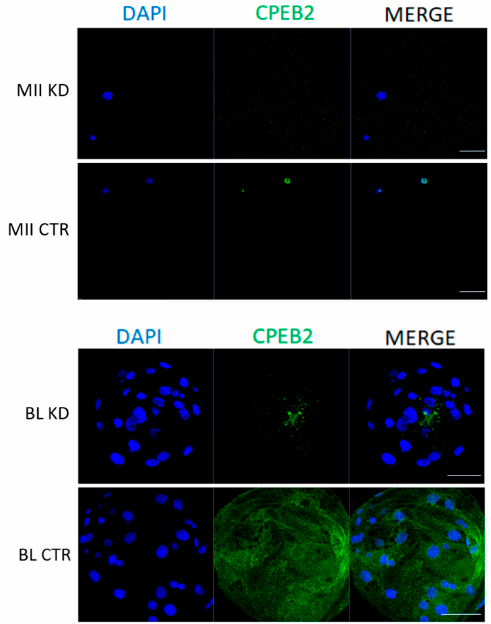
Figure 7. Efficiency of CPEB2 KD during oocyte maturation and embryonic development at the protein level. Representative confocal images show the immunocytochemical detection of CPEB2 (green) protein in porcine MII oocytes and blastocyst (BL). DNA was stained with DAPI (blue). A minimum of 30 oocytes and embryos derived from four independent replicates were analyzed. Scale bars = 100 μ m.